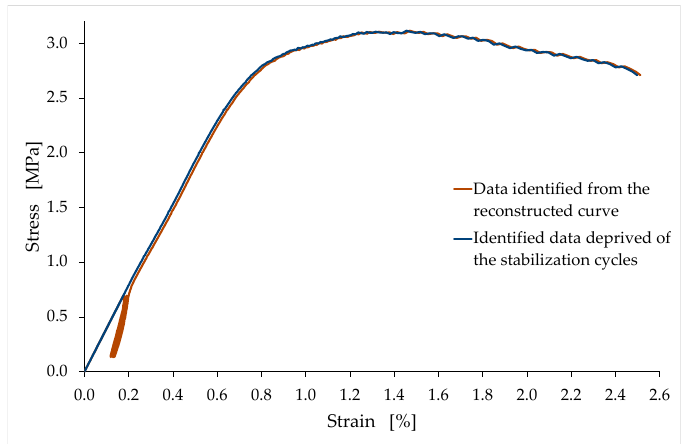
Figure 9. Elimination of the stabilization cycles from the stress/strain curve: LT6 specimen.